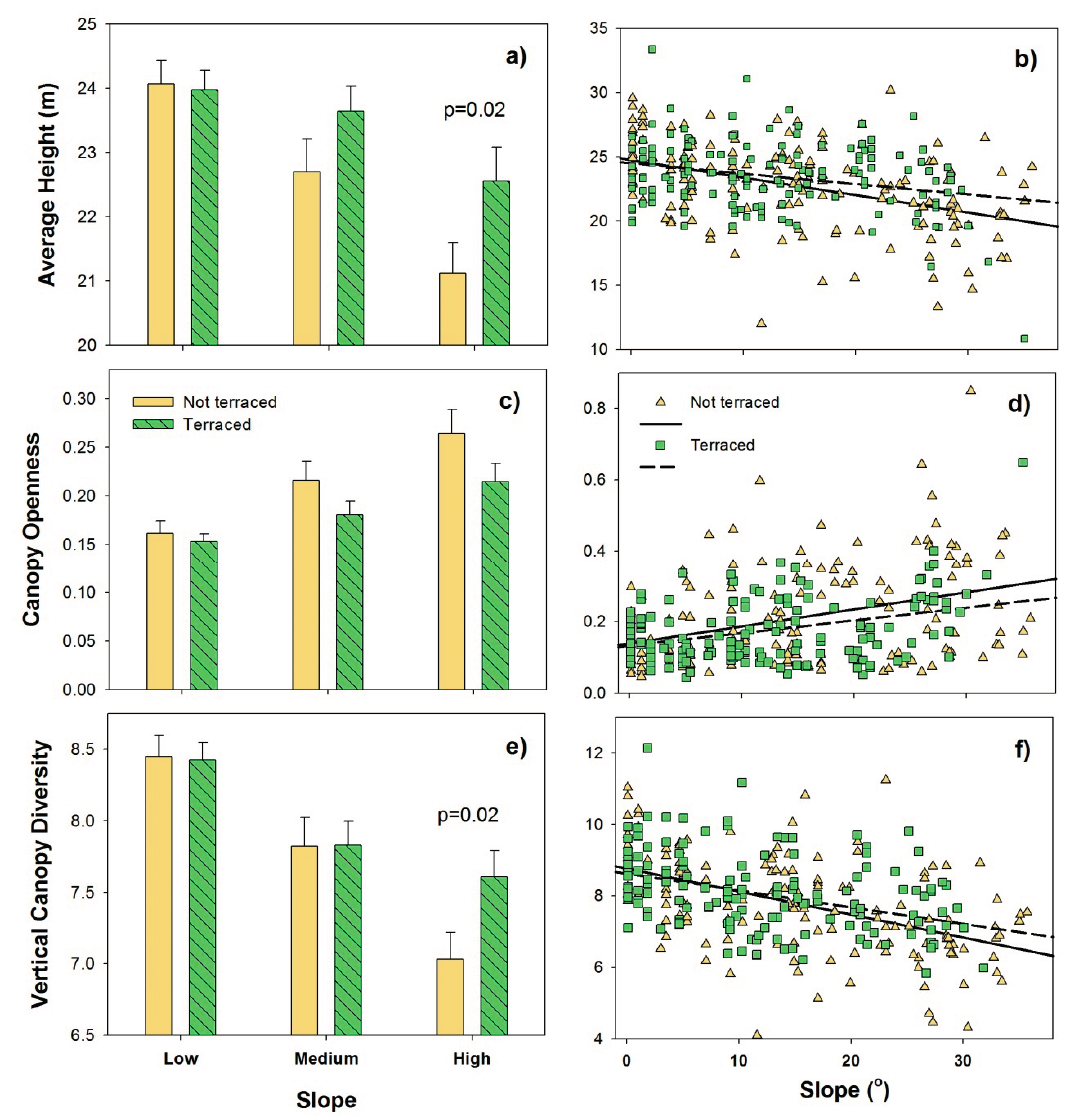
Figure 5. Relationships of LiDAR-derived values of ( a , b ) average canopy height ( c , d ) canopy openness, and ( e , f ) vertical canopy diversity from terraced and not terraced plots as a function of topographic slope. Significant differences between terraced and non-terraced areas in average values (detected with a t -test) for low (0°–10°), medium (10°–20°), and high (>20°) slopes are designated with p